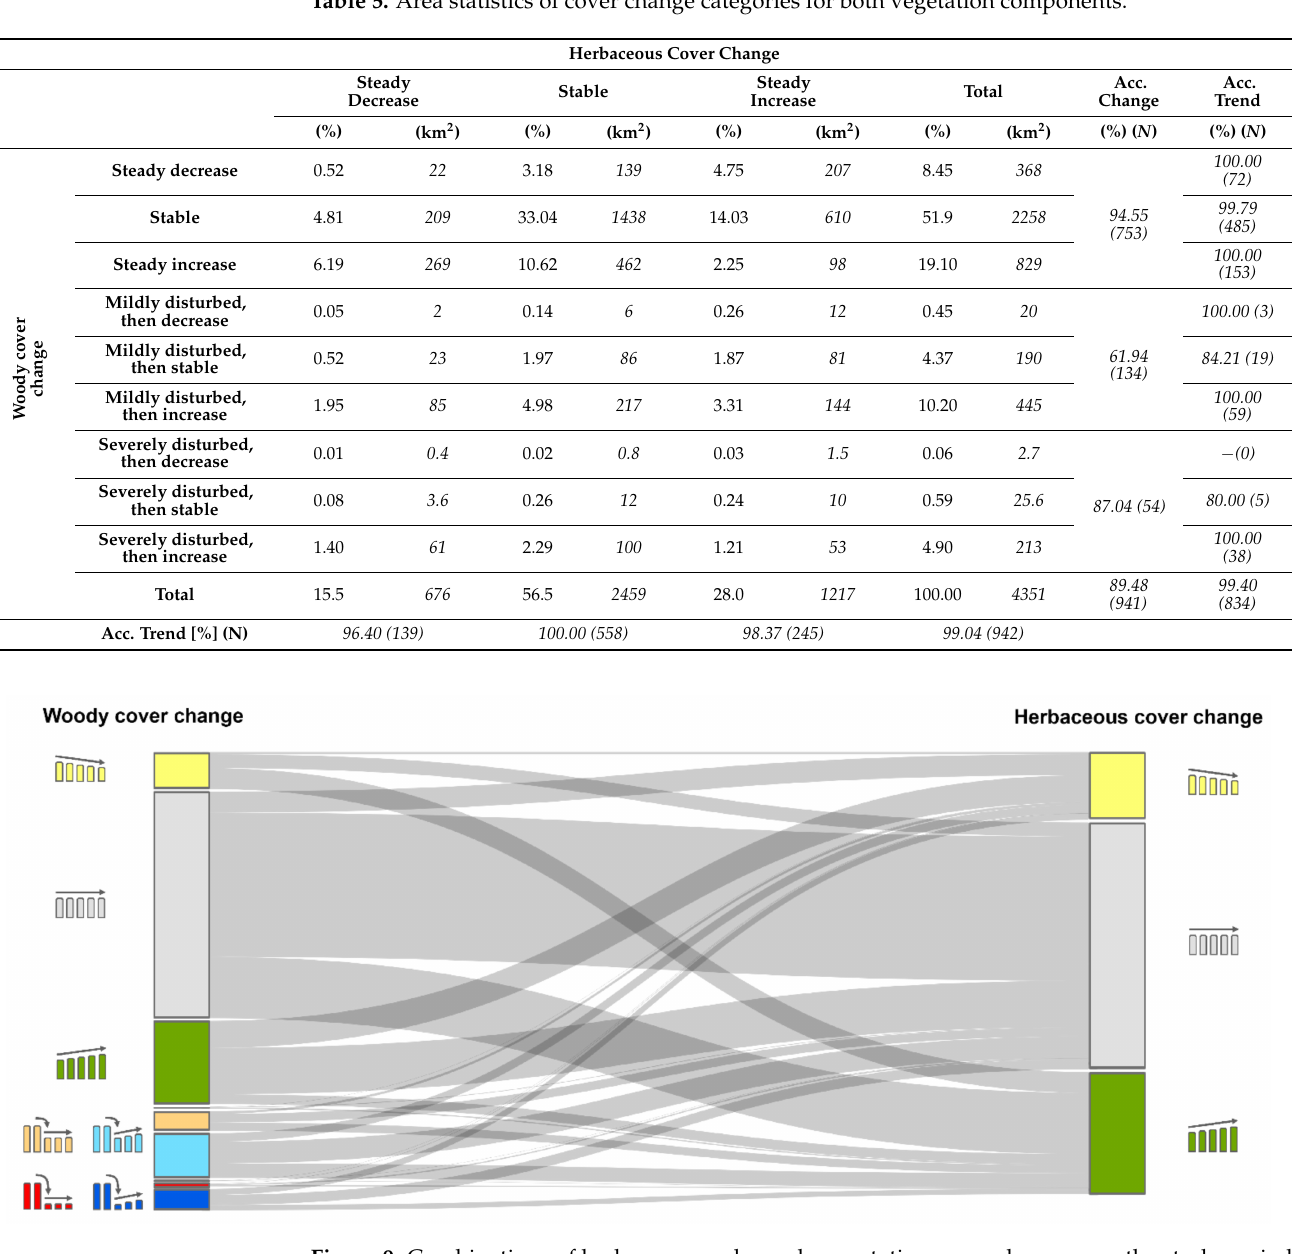
Figure 9. Combinations of herbaceous and woody vegetation cover change over the study period 1984–2006. The width of the links is related to the area under the respective change combination. Numeric data in Table